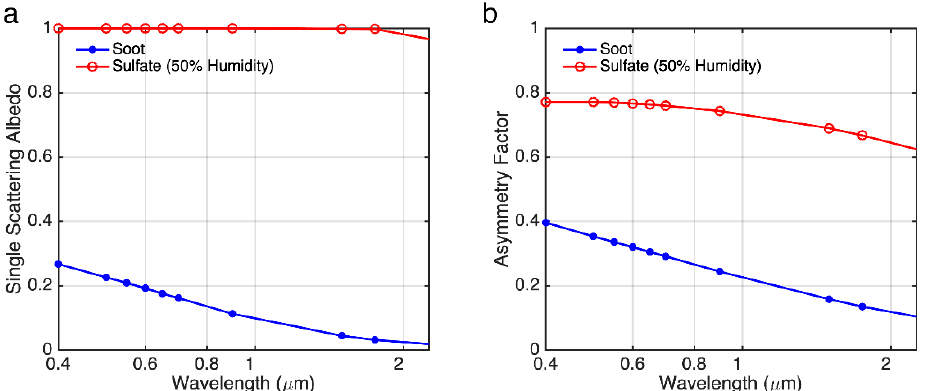
Figure 10. Spectral dependence of single scattering albedo ( a ) and asymmetry factor ( b ) for soot and sulfate (50% humidity) obtained from the OPAC database.